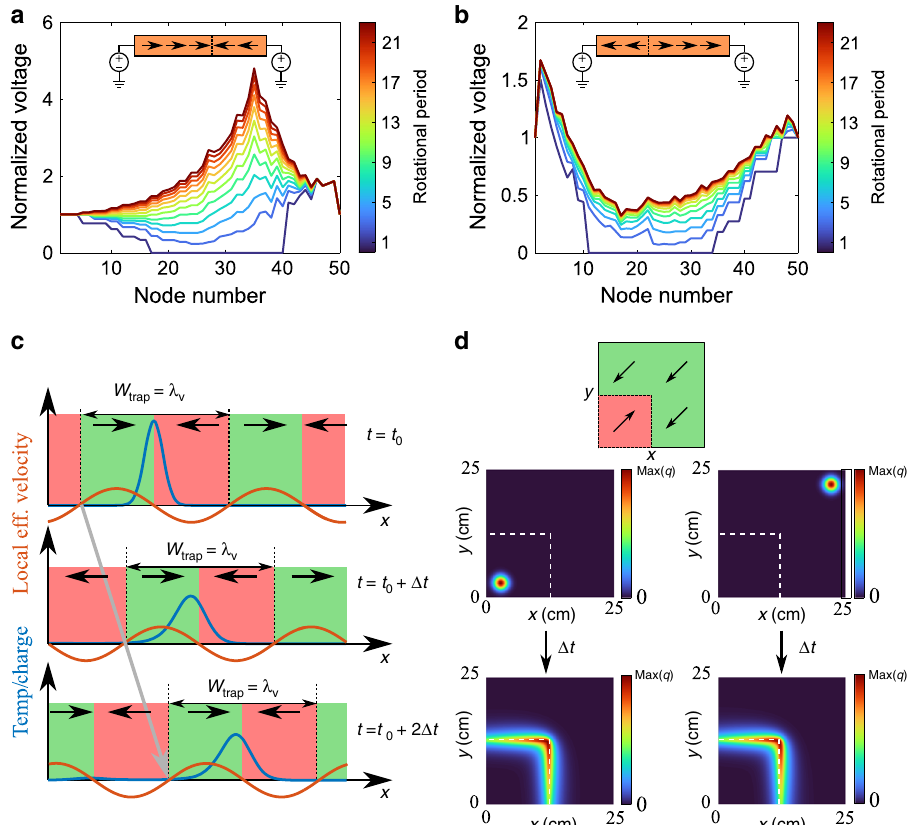
Fig. 3 Accumulation of diffusive quantity at domain boundaries within the spatiotemporal metamaterial. Simulation results showing theoretical time evolution for the time-averaged voltage in a two-domain metamaterial with ( a ) converging (trap) and ( b ) diverging (anti-trap) effective velocities, achieved using different magnitudes and signs of the relative phase between modulations of the switches and the capacitances. In both cases, the steeper steady- state solution (right side in a and left side in b ) is the result of a 1.5 factor in the amplitude of the capacitance modulation with respect to the opposite side. c Mobile diffusion trap based on the use of different frequencies and wavelengths for the spatiotemporal variations of conductivity and capacity, leading to propagating sinusoidal modulation of the effective biasing velocity capable of gathering and moving localized distributions of diffusive quantities. d Simulation results of the diffusive quantity for a corner-shaped trap based on a two-dimensional, two-domain metamaterial demonstrated under two different initial